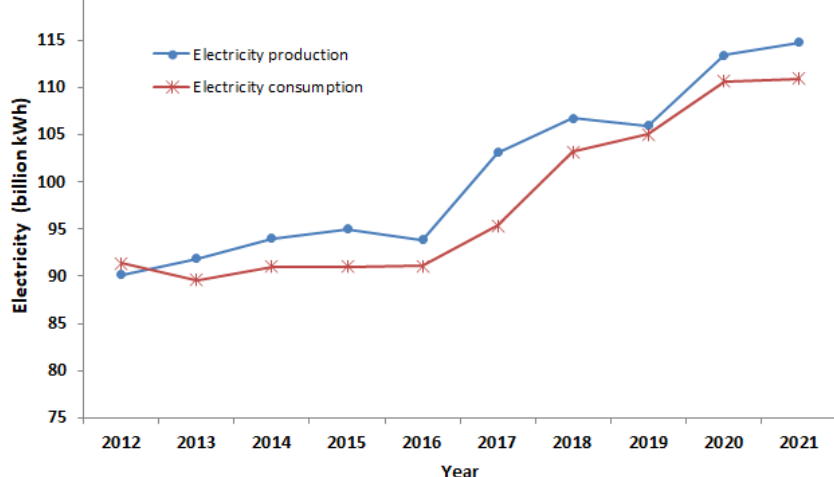
Figure 2. Evolution of electricity generation and demand in Kazakhstan. Data for figure from [36]. Although 80% of the country’s electricity generation comes from 63 coal-fired plants lo- cated in the northern coal-producing regions, Kazakhstan also has five hydroelectric power stations, which give the country an overall installed generating capacity of 19.9 GW [37]. Kazakhstan’s hydroelectric facilities are located primarily along the Irtysh River, which flows from China across northeast Kazakhstan. In terms of output, the leading position is held by condensing power plants, accounting for about half of the energy generated by power plants, followed by combined heat and power plants (36.5%), hydroelectric (12.3%) and gas turbine power plants (2.3%) [36].